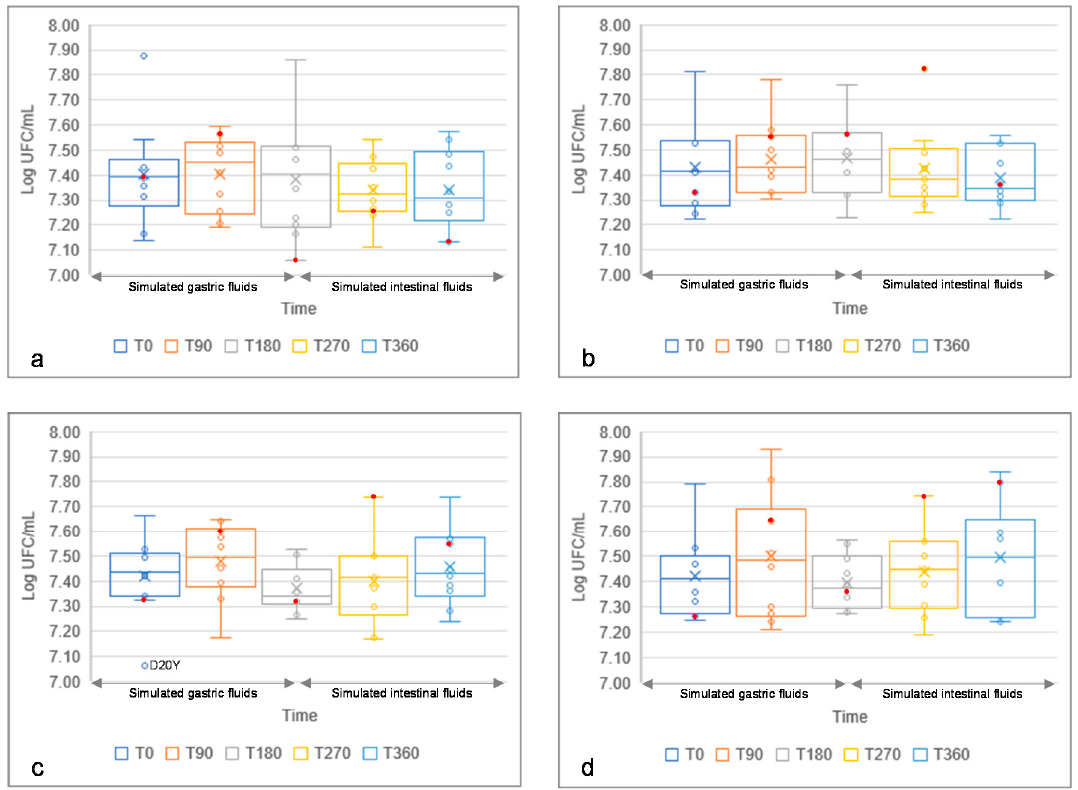
Figure 5. Boxplot showing the survival (Log cfu/mL) of 10 Saccharomyces cerevisiae strains under simulated gastric conditions (0–180 min) at pH 2.0 ( a ), 3.0 ( b ), 8.0 ( c ) and 2.0 with added reconstituted skim milk (10%) ( d ), and further intestinal digestion (180–360 min) at pH 8.0. Circles indicate the isolates; the red ones indicate the commercial probiotics’ yeast from Codex. Median values are reported (×). The top and the bottom of the box represent the 75th and 25th percentile of the data, respectively. The top and the bottom of the bars represent the 5th and the 95th percentile of the data, respectively.